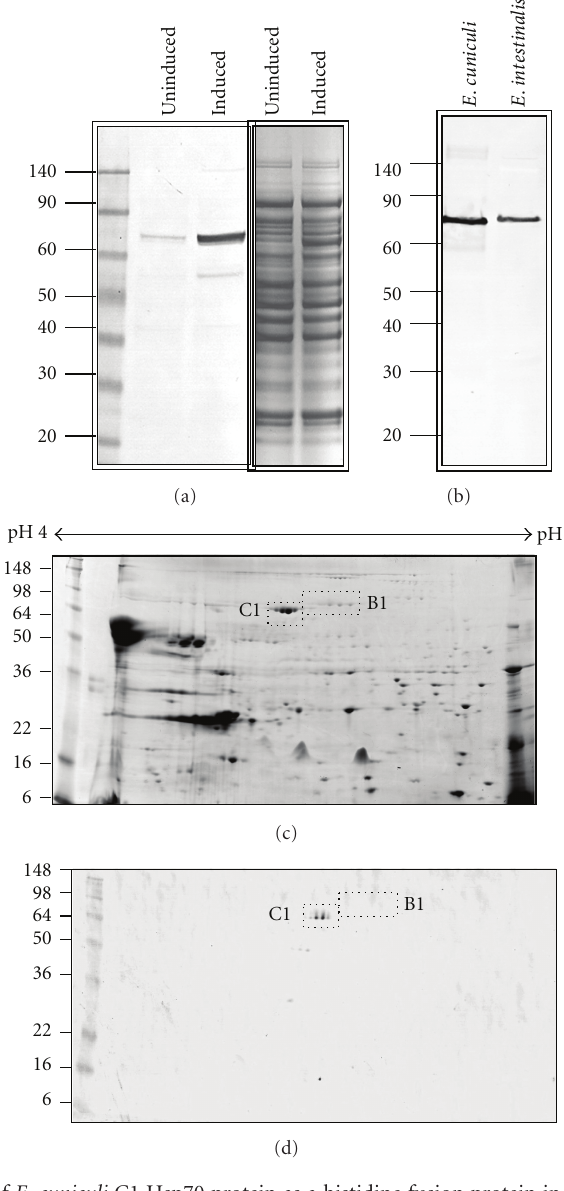
Figure 1: Heterologous expression of E. cuniculi C1 Hsp70 protein as a histidine fusion protein in E. coli and Western blot analysis using purified C1 antibodies. A Coomassie stained SDS-PAGE gel ((a), right panel) of uninduced and IPTG induced expression of the recombinant protein shows a ∼ 76 kDa protein in the induced lane. A Western blot of the SDS-PAGE gel was performed using histidine-tag-specific antibodies ((a), left panel) confirmed the recombinant protein induction. (b) A single ∼ 76 kDa band was detected on 1D Western blot of E. cuniculi and E. intestinalis total spore protein using purified C1 Hsp70 protein antibodies. (c) The C1 (ECU02 0100) and B1 (ECU03 0520) Hsp70-related proteins were identified from a Coomassie stained 2D SDS-PAGE gel of E. cuniculi total spore protein by MALDI-MS analysis of trypsin digested gel spots. (d) Western analysis of the 2D gel using the C1 specific antibodies detected only the C1 protein